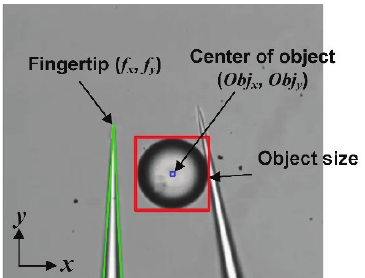
Figure 3. Position detection of the left fingertip and the center of an object.